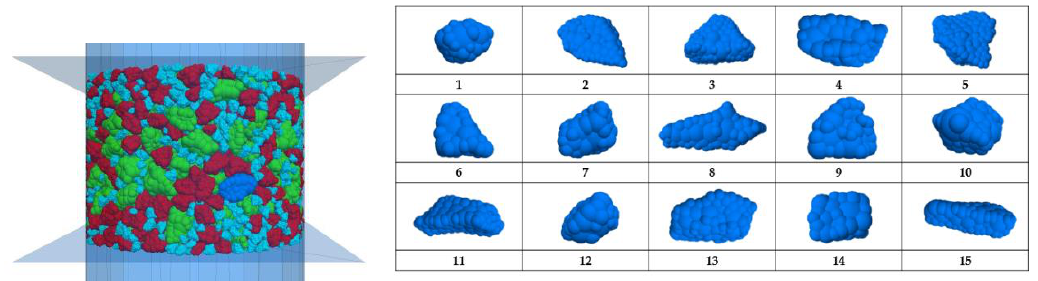
Figure 12. The compacted mixture with real aggregate shape and 15 aggregate shapes.